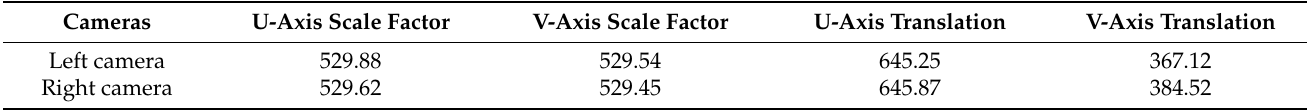
Table 1. Calibration results of the binocular